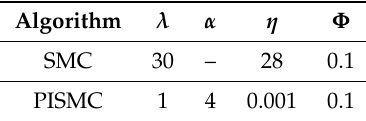
Table 1. Parameters used for comparison of cost